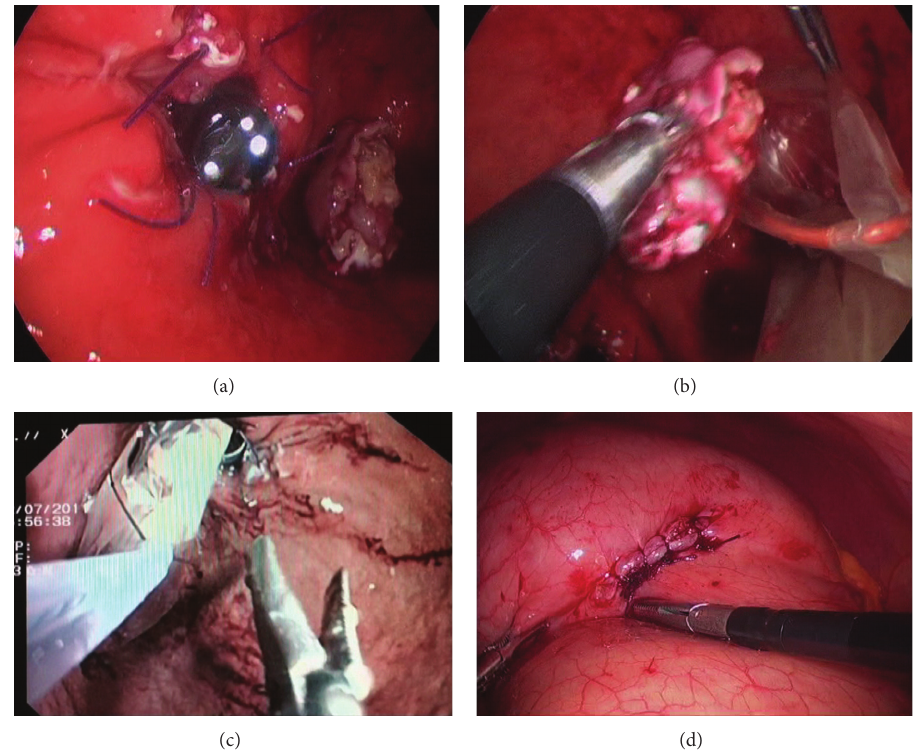
Figure 3: (a) Confirmation of good passage through esophagogastric junction after closure with endoscope. (b) Introduction of tumor in endobag. (c) Tumor removal through gastroscope. (d) Closure of